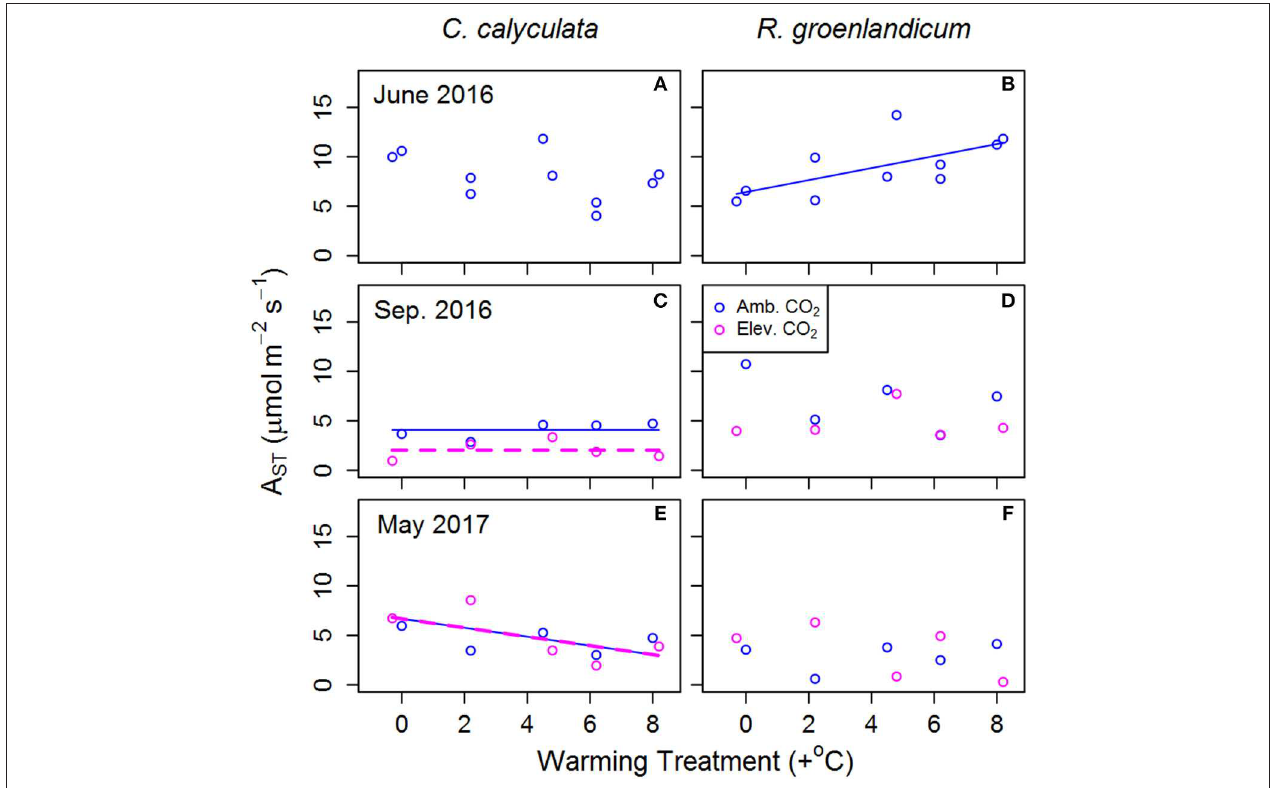
FIGURE 2 | Mean net photosynthesis per unit leaf area at 25 ◦ C, 400 ppm [CO 2 ] and saturating light ( A ST ) for two shrub species at the SPRUCE site in each plot, for newly expanded ( A,B ; June 2016), mature ( C,D ; September 2016), and overwintered ( E,F ; May 2017) leaves. Warming treatments indicate growing season (April–October) mean daytime temperature difference from the control plot and color indicates ambient (400 ppm) or elevated (900 ppm) [CO 2 ] treatments. Lines indicate fit of best model, as evaluated using Akaike Information Criterion corrected for sample size (AICc). Panels without lines have intercept-only best models as shown in Table 1 .